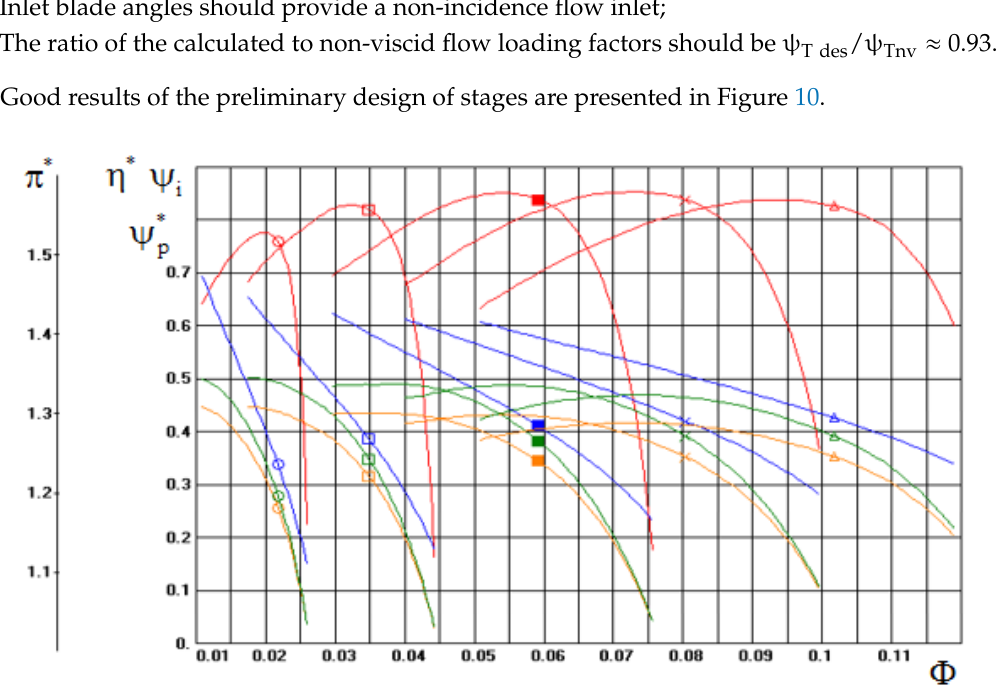
Figure 10. Characteristics of a stage series with Φ des = var. Flow path by the preliminary design. Green—pressure ratio, red—efficiency, blue—work coefficient, orange—polytropic coefficient.The efficiency and the flow rate range of the stages are close to the best values, which indicates a satisfactory quality of the preliminary design.